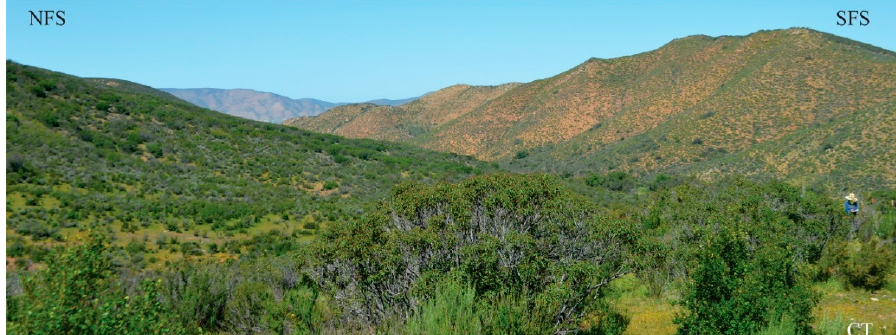
Figure 2. Contrasts between vegetation on north-facing slopes (NFS), south-facing slopes (SFS) and control (CT) sites during the wet season.